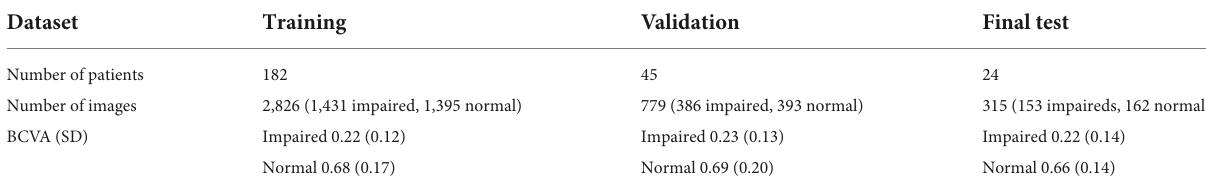
TABLE 2 The details of the training, validation, and final test datasets list the numbers of allocated patients and optical coherence tomography (OCT) images and average BCVA values of patients. Dataset Training Validation Final test Number of